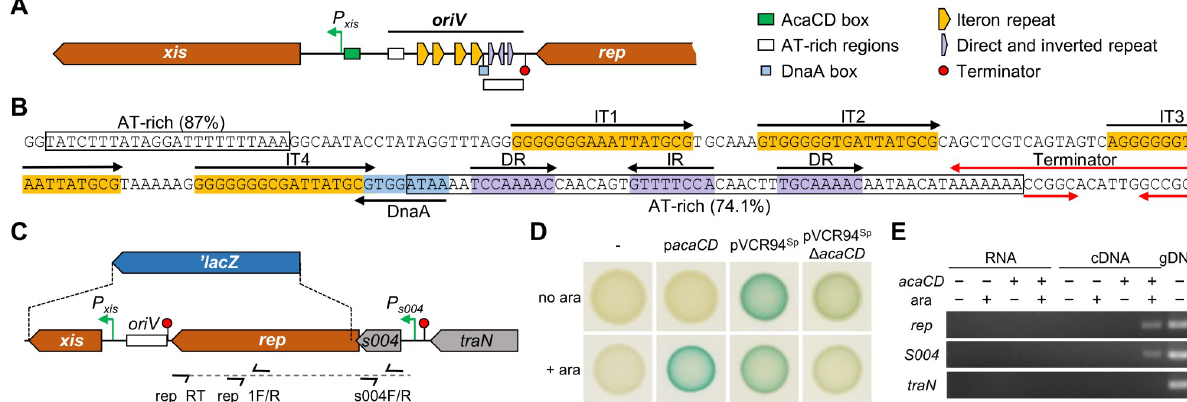
Fig 4. Identification of the oriV locus of SGI1. A. Schematic map of the xis - S003 intergenic region of SGI1 containing oriV . B. Sequence of the oriV region of SGI1. Sequence features are indicated and color-coded as in panel A. The stem-loop of the putative rho-independent transcriptional terminator located downstream of S003 has a calculated free energy ( Δ G ) of -8.9 kcal/mol (ARNold). C . Schematic representation of the S004 - rep locus and translational rep ’-’ lacZ fusion. The translational lacZ fusion was introduced at position 3,246 after the fifth codon of rep (refer to S6A Fig for details). The relative positions of reverse transcription primer rep_RT as well as PCR primers used to amplify rep and S004 fragments are indicated. The dotted line shows reverse transcription product. D . rep expression is controlled by AcaCD. β -galactosidase assays of the translational rep ’-’ lacZ fusion in SGI1 Δ xis performed in IncC-free cells (-), and in the presence of pVCR94 or p acaCD without (no ara) or with arabinose (+ ara). E . Analysis on a 1.5% agarose gel from an assay to amplify rep and S004 on the rep_RT cDNA. Genomic DNA (gDNA) and RNA samples in the absence of reverse transcriptase (noRT) were used, respectively, as positive and negative PCR controls.